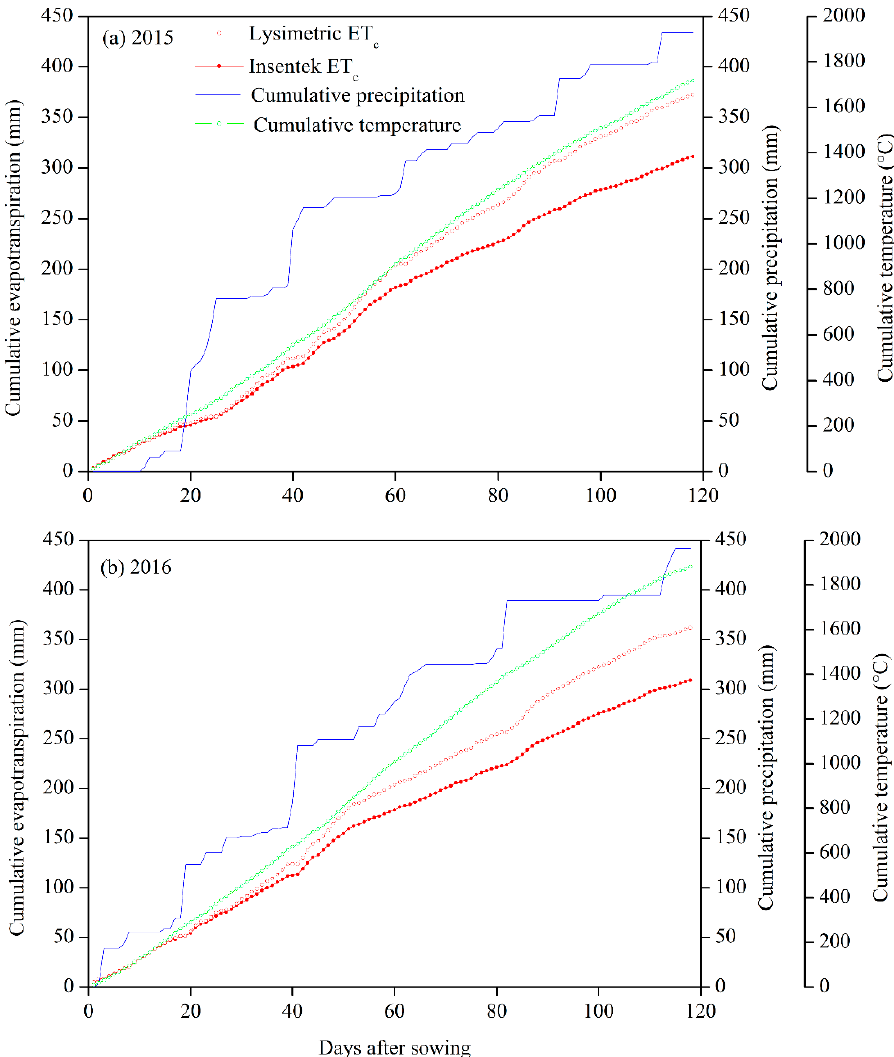
Figure 6. Cumulative evapotranspiration, cumulative air temperature, and precipitation during maize growing seasons of ( a ) 2015 and ( b ) 2016, at the Xuchang Irrigation Experiment Station, in the North China Plain.